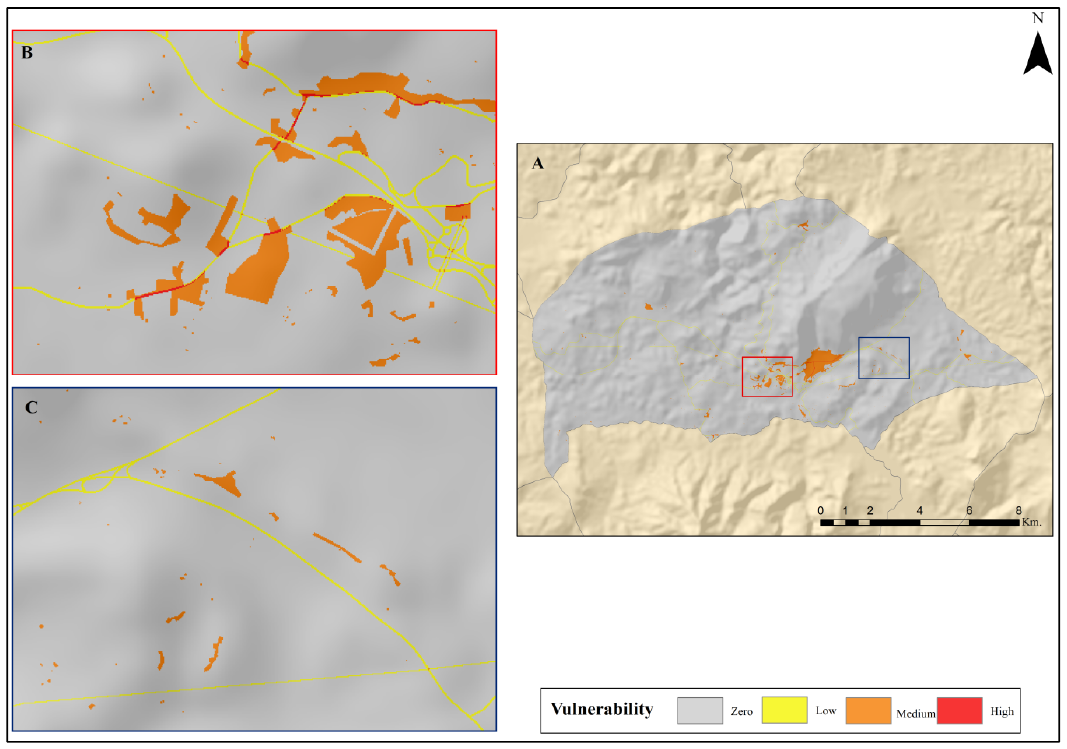
Figure 10. Vulnerability map.